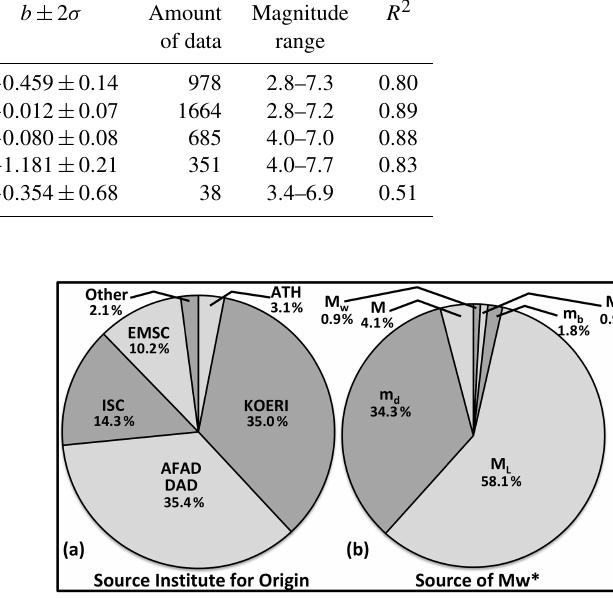
Figure 6. Distribution of the parameters in the homogenized cata- logue. (a) Source institutes for the origin parameters. (b) Percentage of the magnitude scales used for M ∗ w